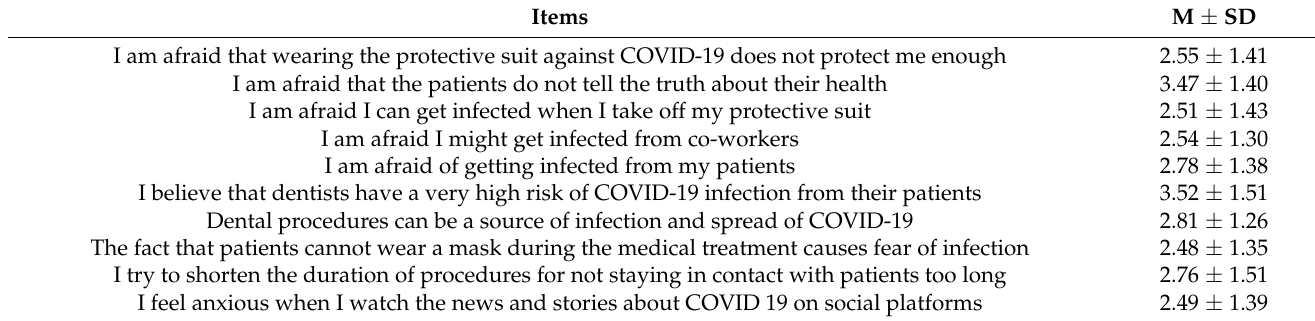
Table 2. Fear of infection with COVID 19—self-rated items 1